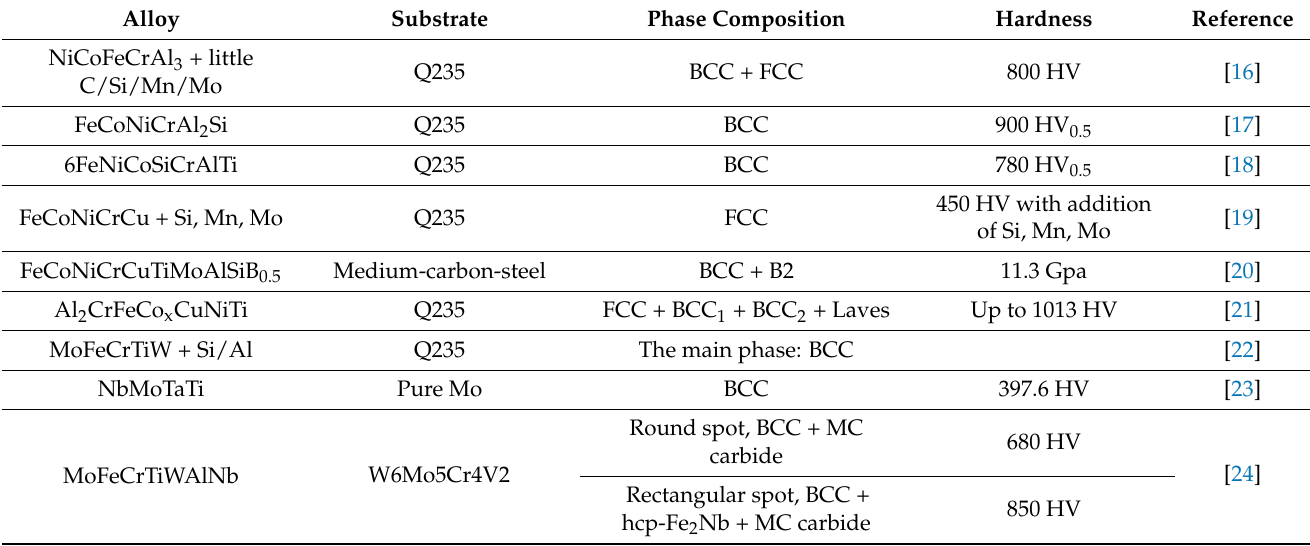
Table 1. Phase composition and hardness of high-entropy alloy coating prepared with laser